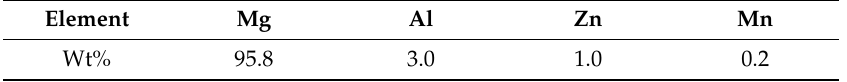
Table 1. Chemical composition of AZ31B magnesium alloy (X-ray fluorescence